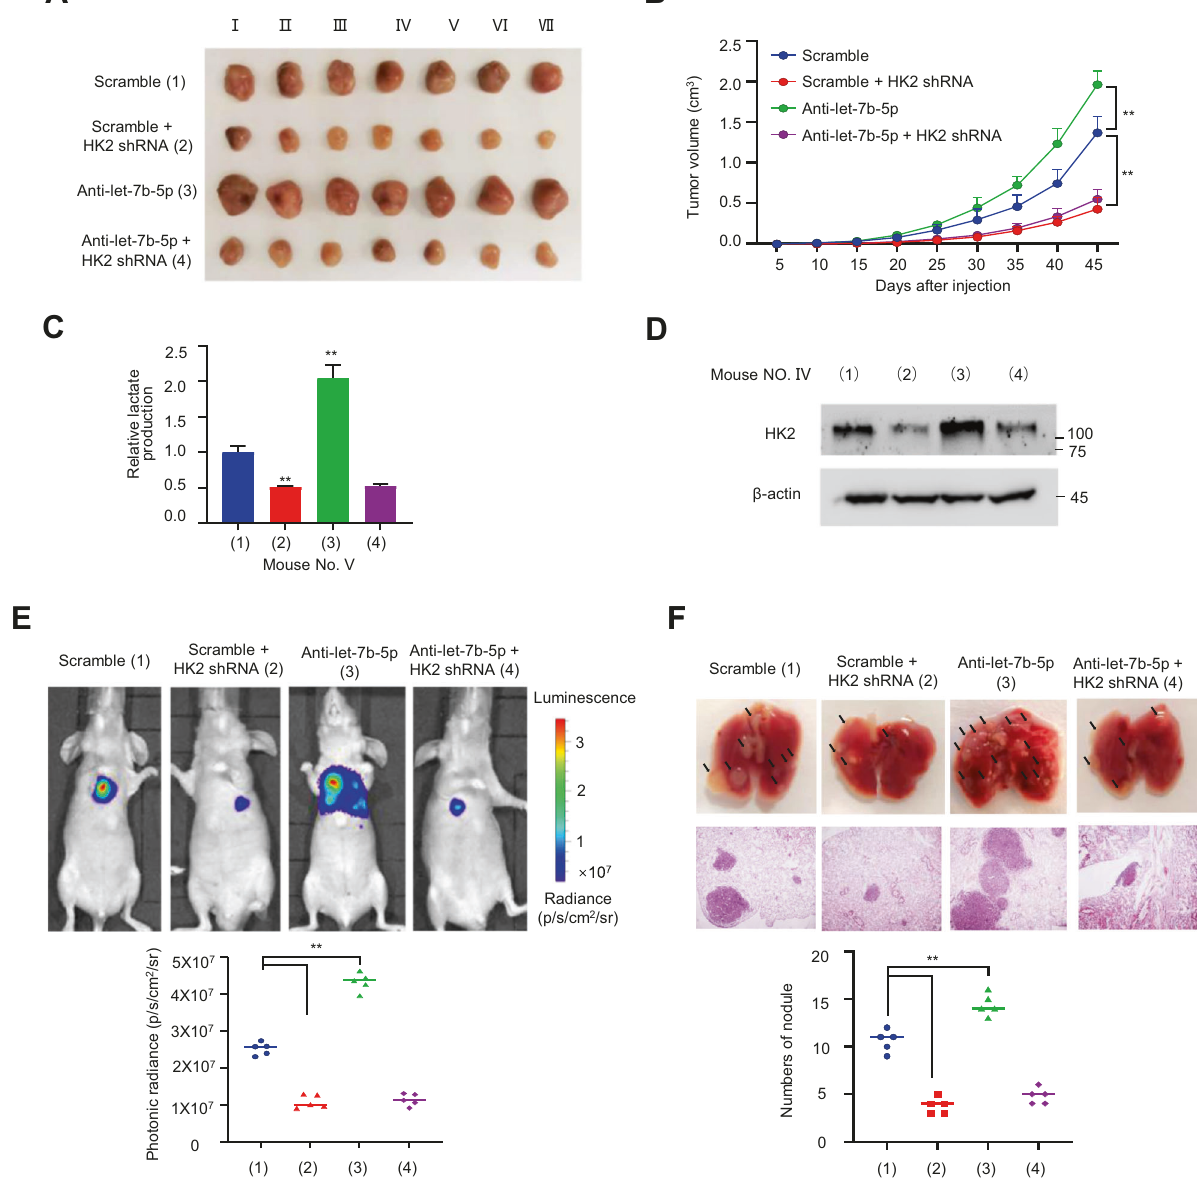
Fig. 6 Let-7b-5p/HK2 axis modulates glycolysis, tumor proliferation, and metastasis in mice. A , B Control or HK2 shRNA MDA-MB-231 cells were treated with anti-let-7b-5p (antagomiR-let-7b-5p) or scramble (antagomiR-NC) and injected into nude mice. Tumor size was detected at indicated times, and a proliferation curve was drew ( n = 7, mean ± SD). C Lactic acid concentration of representative tumors from ( A ) was assayed ( n = 3, mean ± SD). D Western blot of HK2 expression in representative tumors from ( A ). E Representative bioluminescence images were collected from lung metastasis models by injecting indicated MDA-MB-231 cells into the tail vein of nude mice ( n = 5). The bioluminescence signal is presented by an overlaid false-color image with the signal intensity indicated by the scale. F Representative photographs of lungs from E and H&E staining of lung tissue sections. The scatter diagram showed the number of metastatic discoveries have indicated that there are some correlations with its ability to dampen glycolysis. In addition, let-7b-5p between such BC markers, let-7b and HK2. Let-7b has been associates glycolysis with breast tumor proliferation and lung shown to inhibit the expression of ER- α , which is inversely metastasis in vivo. correlated with let-7b in BC tissues [41, 42]. Estradiol (E2) Estrogen receptor (ER) and breast-cancer susceptibility gene treatment has been found to promote HK2 expression in (BRCA) are widely recognized as important markers for BC. ER is paclitaxel-resistant BC cells [43]. Dysregulation of let-7b has also not only a powerful predictive and prognostic marker but also a been observed in BRCA2 germ-line mutation carriers between valuable target for the treatment of hormone-dependent breast invasive breast cancer and asymptomatic normal breast tissue cancer. BRCA, which includes BRCA1 and BRCA2, is a critical tumor [44]. Furthermore, BRCA1 has been found to repress suppressor gene for BC. Mutations in BRCA can cause chromoso- HK2 expression, reducing glycolysis and attenuating BC cell mal instability, promote cell proliferation, and hinder normal cell migration [45]. differentiation, leading to the development of BC. Recent